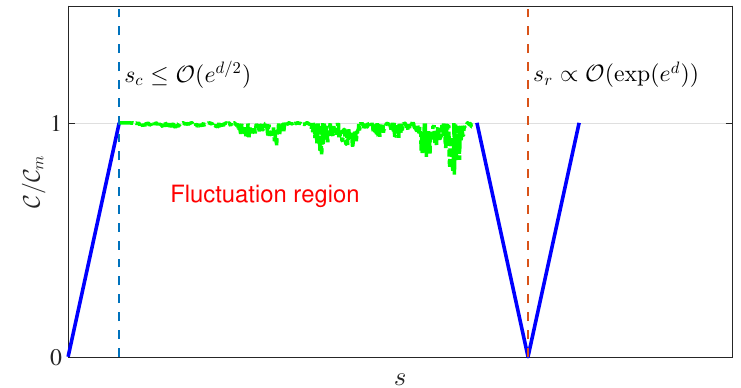
Figure 4 . The conjectured schematic diagram for the complexity evolution of the operator exp( Hs ), where H is a constant generator in su ( n ). The complexity (cid:12)rst grows linearly when s < s c and p reaches its maximum at the time s = s c (cid:20) O ( n ) / O ( e d= 2 ), where d is proportional to the classical degree of freedom of the system i.e., the size of classical phase space. At a very large time s = s r / O (exp( e d )), the quantum recurrence occurs and the complexity goes down to